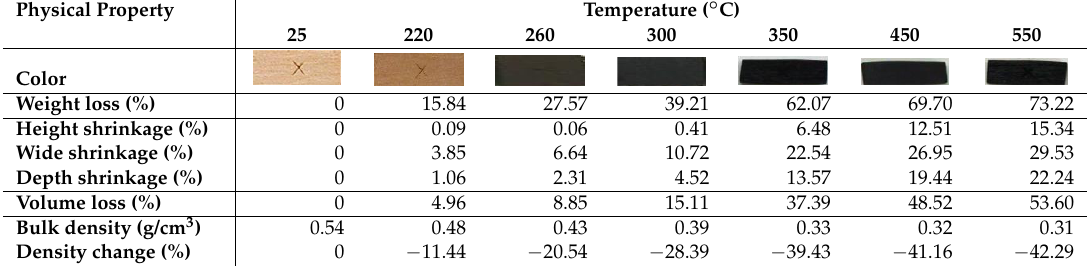
Table 2. Physical property changes of untreated and treated woods at each treatment temperature.